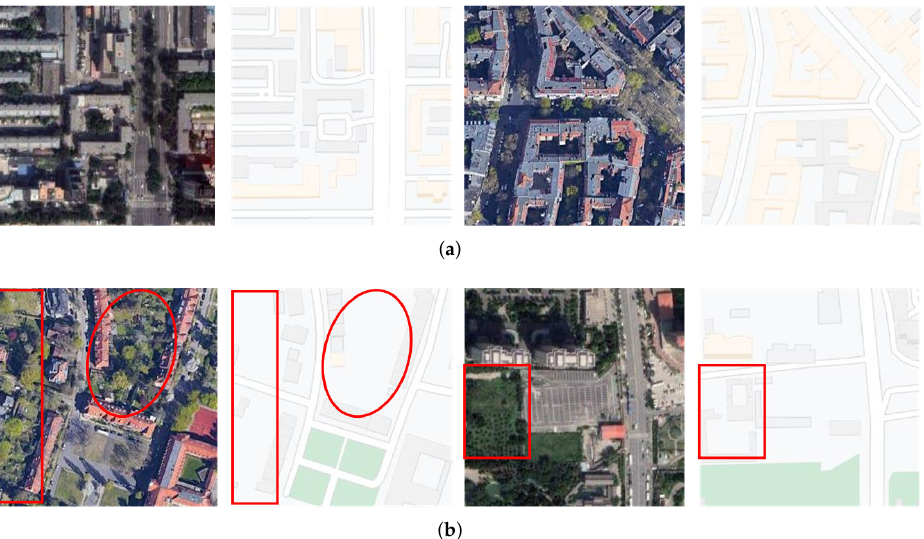
Figure 8. Issues on artificial maps. ( a ) The colors of the buildings in the map are artificially divided into two types (pale yellow and gray), but there is no difference in the remote sensing images. ( b ) Green areas in maps are not